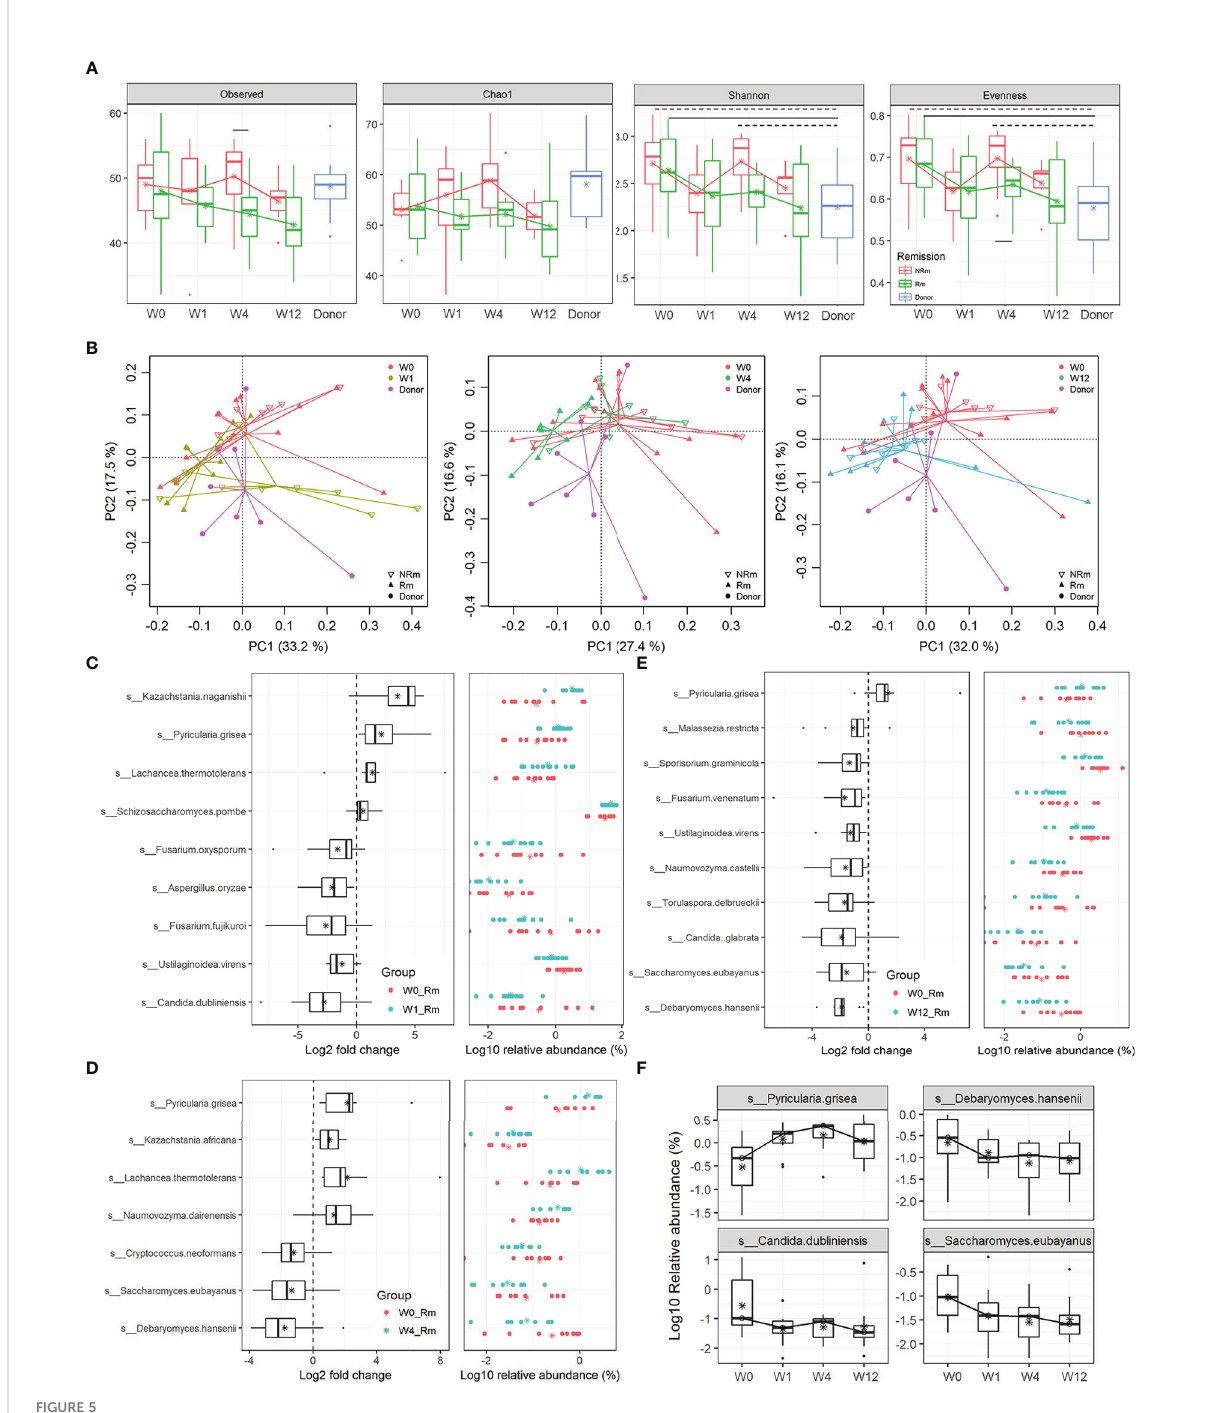
FIGURE 5 Alterations in gut fungal taxa associated with Rm after FMT. (A) a -diversity indices in samples from donors and patients who received remission (Rm) or not (NRm) were analyzed, including Observed species, Chao 1, Shannon, and Pielou ’ s evenness. (B) Clusters of gut fungal community were analyzed using PCA of the Euclidean distance of OTU abundance. The circle represented the donor, the triangle represented patients who received remission (Rm), and the inverted triangle represented patients who did not receive remission (NRm). (C – E) The changes in relative abundances of fungal species were assessed by the paired rank-sum test between week 0 and other time points (weeks 1, 4, and 12) ( p < 0.05). Box plots showed the species signi fi cantly changed in the Rm group at different time points. (F) The relative abundance of fungal species in remission patients at different time